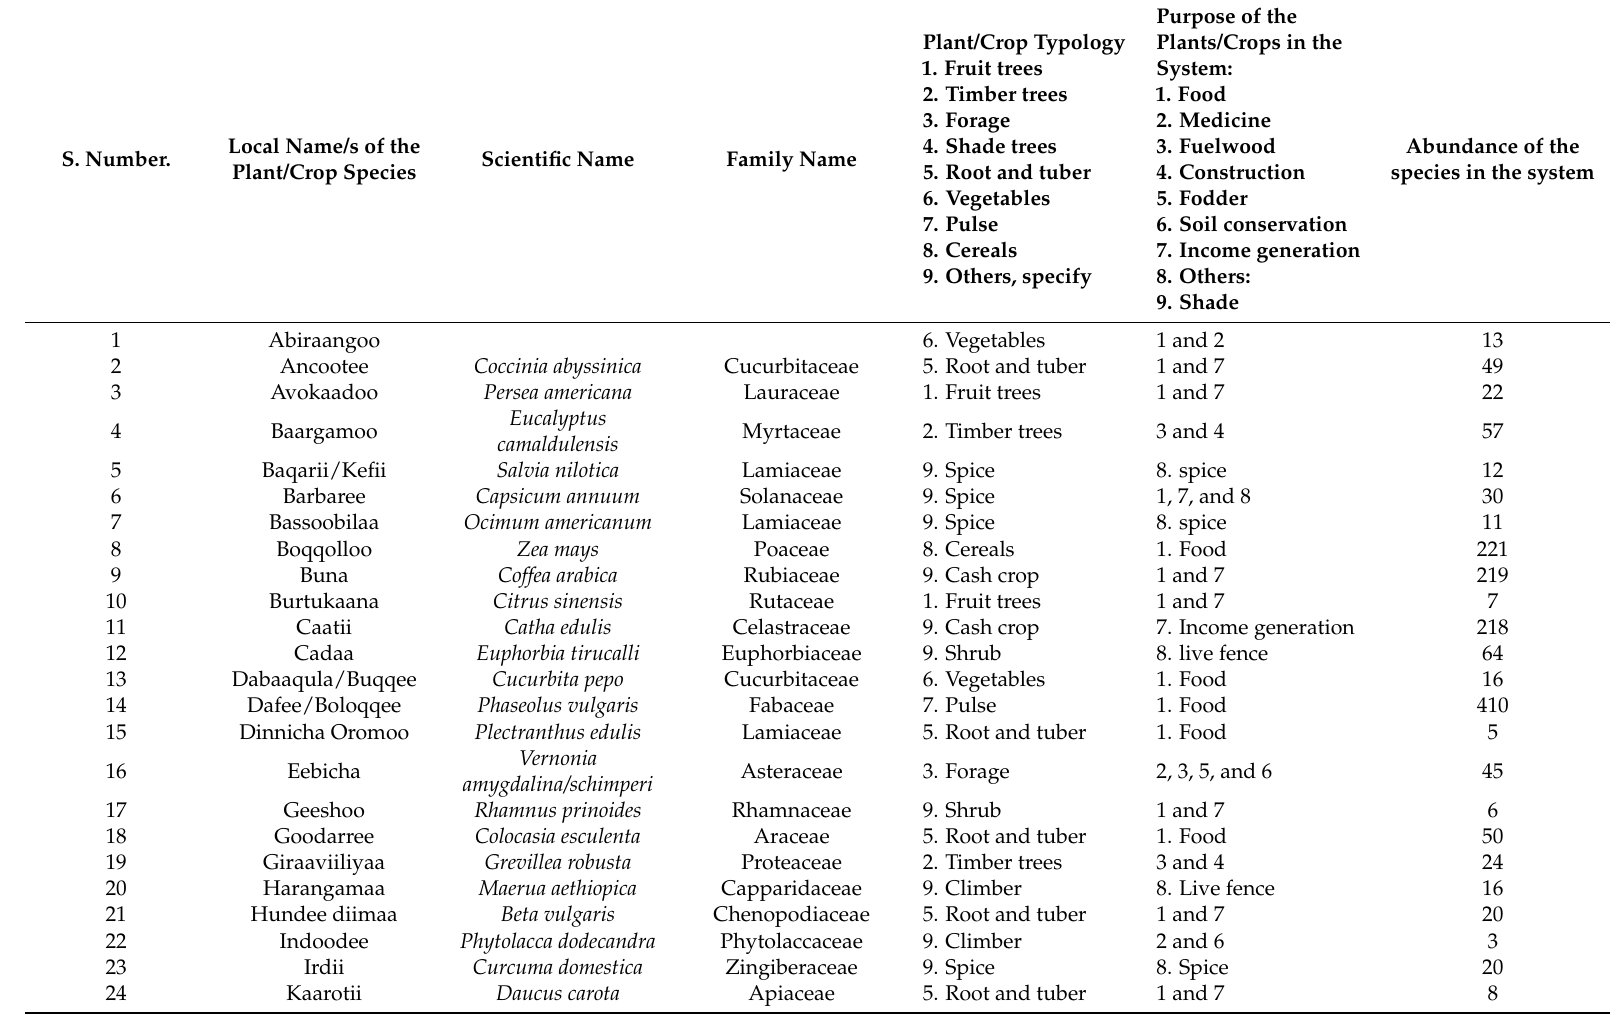
Table A2. Species Compositions of Homegarden